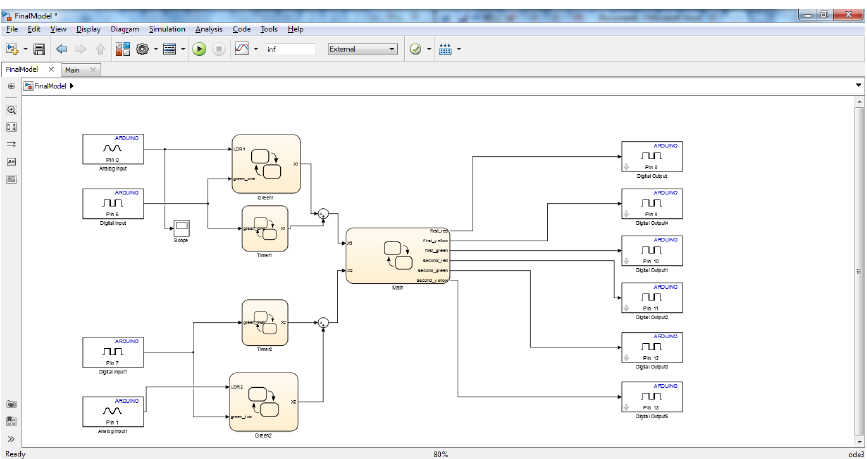
Fig. 6. Arduino-based traffic lights implementation using